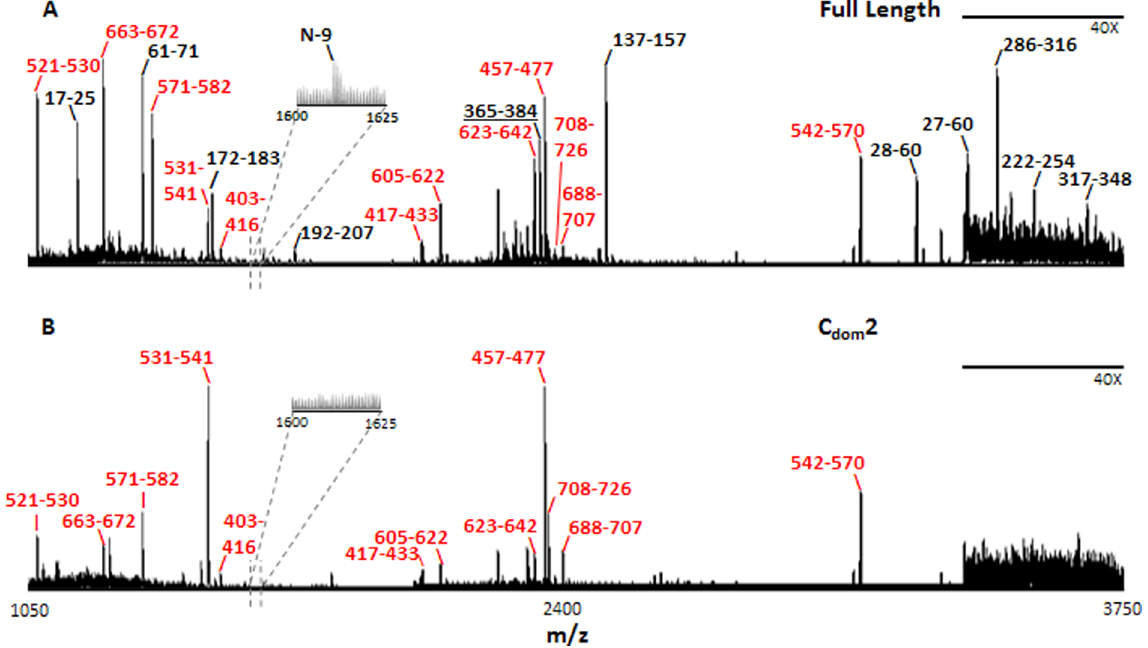
Figure 6. Maldi-ion trap mass spectra of exhaustive in-gel trypsin digest products. Spots were excised from the two dimensional gel (Figure 5). (A) Full length D. melanogaster tRNase Z. (B) A representative C dom 2 partial proteolysis polypeptide. Start and end residue numbers are indicated for all peaks that can be positively assigned to tRNase Z L tryptic peptides. See table 1 for details. Peptides present in both samples are labeled in black; those present in the full length protein but not C dom 2 are labeled in red.